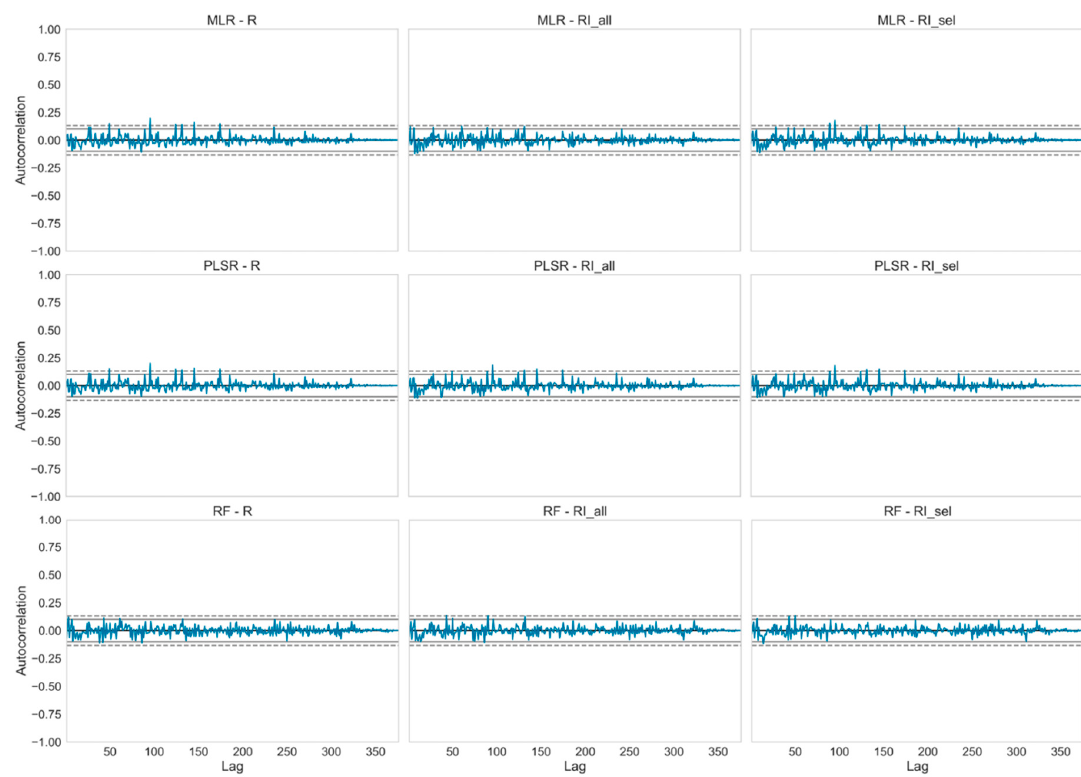
Figure A2. Standardized residuals of the model validation (30% of data points).